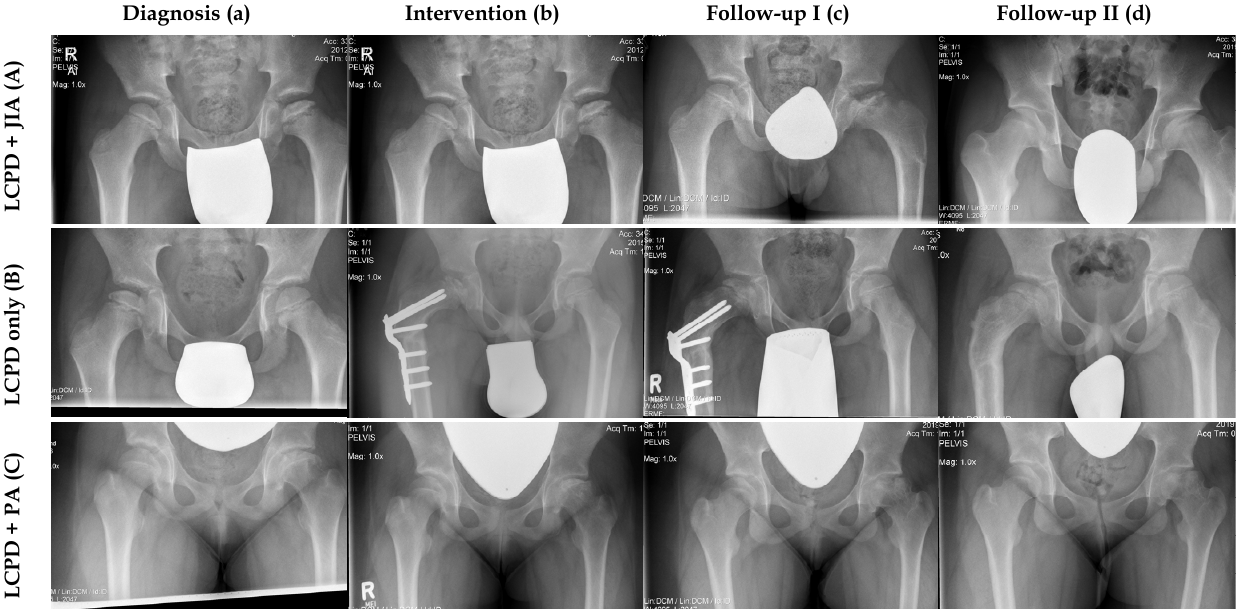
Figure 1. Comparison of three radiological courses between one patient with LCPD only and two patients with concomitant JIA. ( A ) Male patient (Nr. 6) with LCPD and JIA. ( a ) LCPD was diagnosed at the age of 8.7 years (Elizabethtown classification: Ib) and JIA was detected one month later. ( b ) This patient had proximal femoral varus osteotomy (Elizabethtown classification: IIb). ( c ) Anteroposterior radiograph of the pelvis after implant removal (Elizabethtown classification: IIIa). ( d ) This patient had a very good clinical and radiological outcome at the last follow-up (FU: 7.9 years, mHHS: 95, Stulberg: II). ( B ) Male patient with LCPD only (Nr. 9, control group). ( a ) LCPD was diagnosed